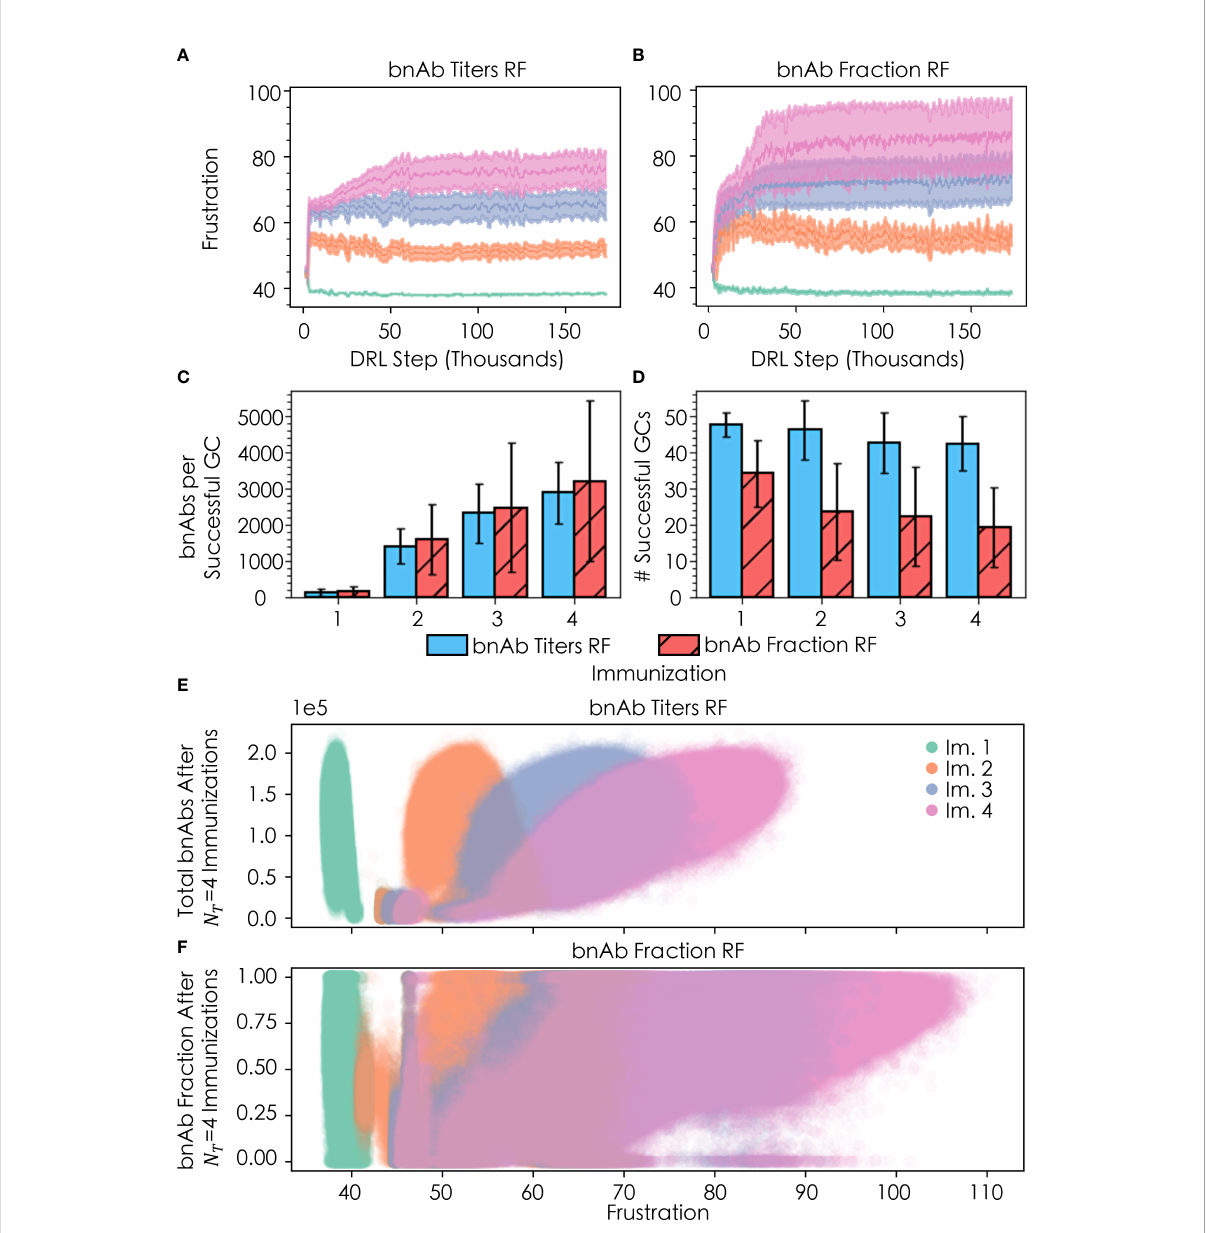
FIGURE 4 Convergence of frustration values F 1 (green), F 2 (orange), F 3 (purple), and F 4 (pink) for (A) the bnAb titers reward function (RF) and (B) the bnAb fraction RF, across four total immunizations; (C) bnAb titers produced per successful GC (out of n=100 GCs) for both RFs after each of the four immunizations; (D) number of successfully terminating GCs after each immunization for both RFs; (E) distribution of bnAb titer response for a given F i after the four immunizations; and (F) fractional bnAb response for a given F i after the four immunizations. In (A, B) , the rolling average +/- the rolling standard deviation is plotted using 500 DRL steps. In (C, D) , error bars are +/- the standard deviation of the respective metric (bnAb titers/successful GC and total successful GCs, respectively). In (E, F) , the y-values shown are the responses after administering all four immunizations; that is, the y-values are plotted as ( F i ∈ 4 , R 4 ) for R 4 ≡ total bnAb titers and bnAb fraction,